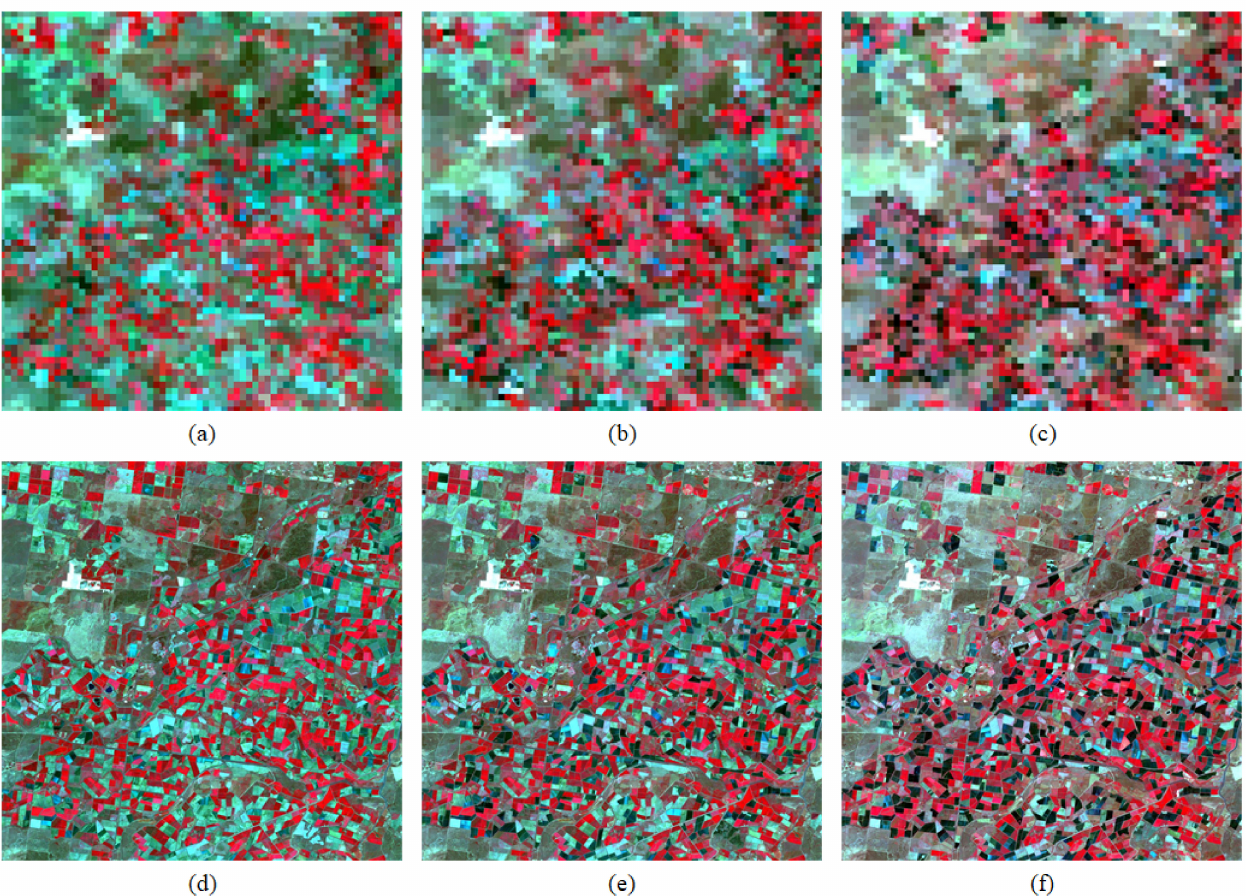
Figure 4. Composite MODIS (top row) and Landsat (bottom row) image pairs on 7 October ( a , d ), 16 October ( b , e ), and 1 November ( c , f ) 2001 from the CIA [31] dataset. The CIA dataset mainly contains significant phenological changes of irrigated